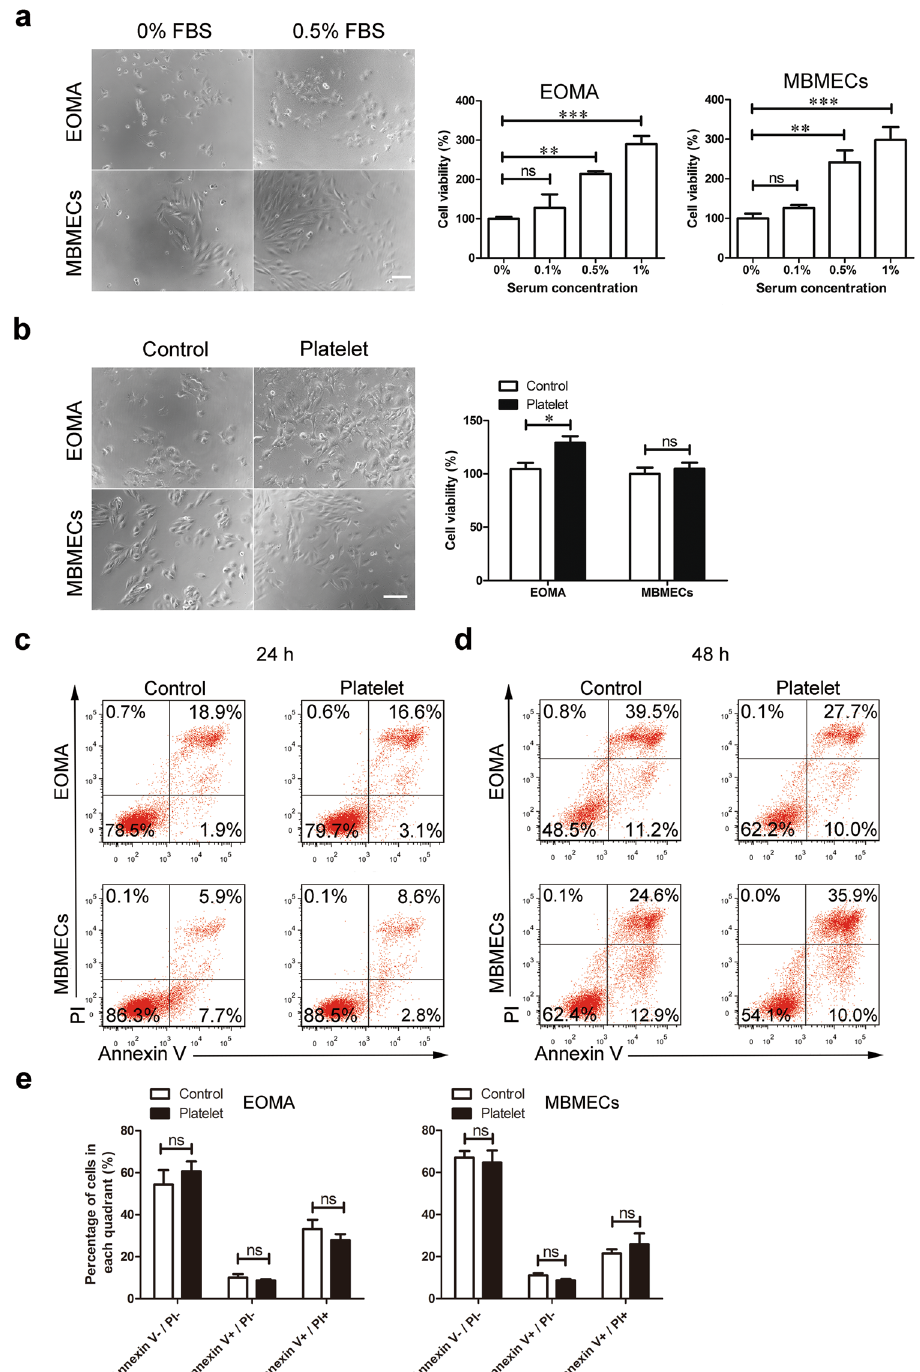
Figure 1. Platelet treatment increased the survival of EOMA cells without affecting cell apoptosis. ( a ) Effect of serum concentrations on the survival of EOMA cells and MBMECs. EOMA cells and MBMECs were cultured in medium with indicated concentrations of FBS for 72 hours. The cell viability was then assessed using the CCK8 assay. Representative images show the morphology of EOMA cells and MBMECs cultured with 0 and 0.5% serum for 72 hours. Scale bar, 50 μ m. n = 5, one-way ANOVA. ( b ) Representative images and the cell viability of EOMA cell and MBMECs after platelet treatment for 72 hours. Scale bar, 75 μ m. ( c , d ) Both EOMA cells and MBMECs were treated with platelets for ( c ) 24 hours and ( d ) 48 hours, stained with Annexin V/PI, and then evaluated via flow cytometry. ( e ) The 48-hour treatment of platelets did not affect apoptotic proportions of EOMA cells. n = 3, t-test. * P < 0.05; ** P < 0.01; *** P < 0.001; ns, not